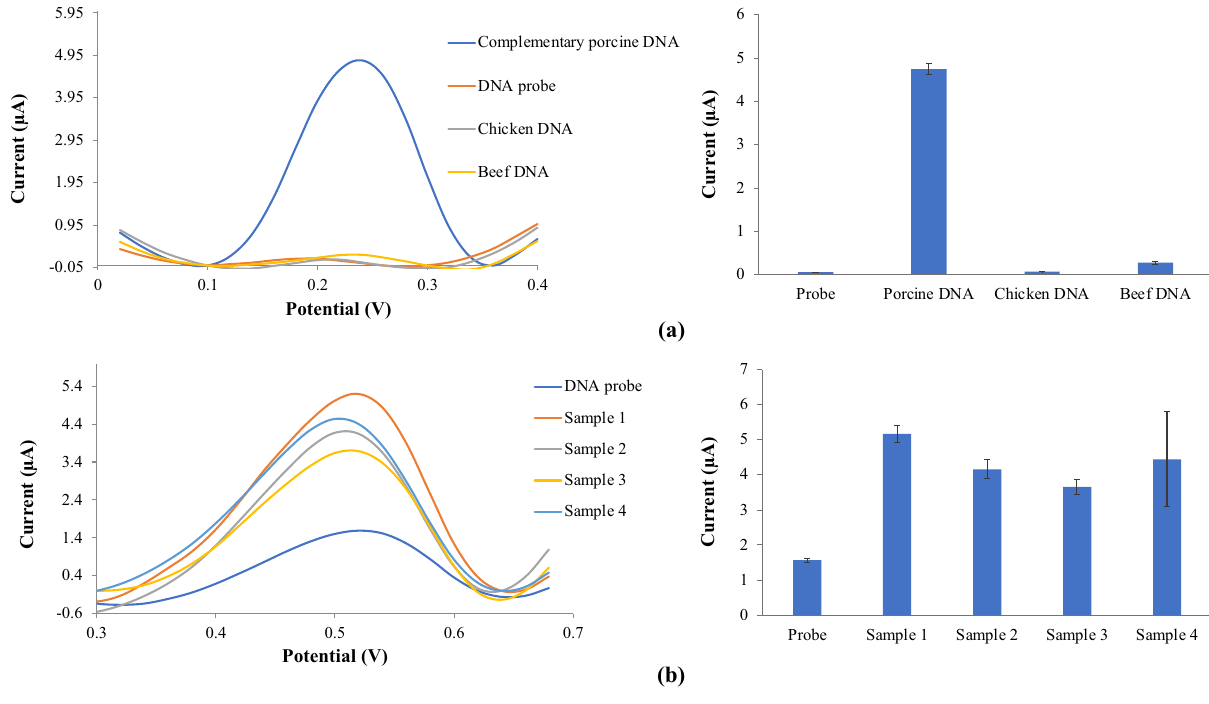
Figure 12. ( a ) porcine DNA biosensor selectivity on complementary porcine DNA, chicken DNA and beef DNA and ( b ) real samples measured with porcine DNA biosensor.